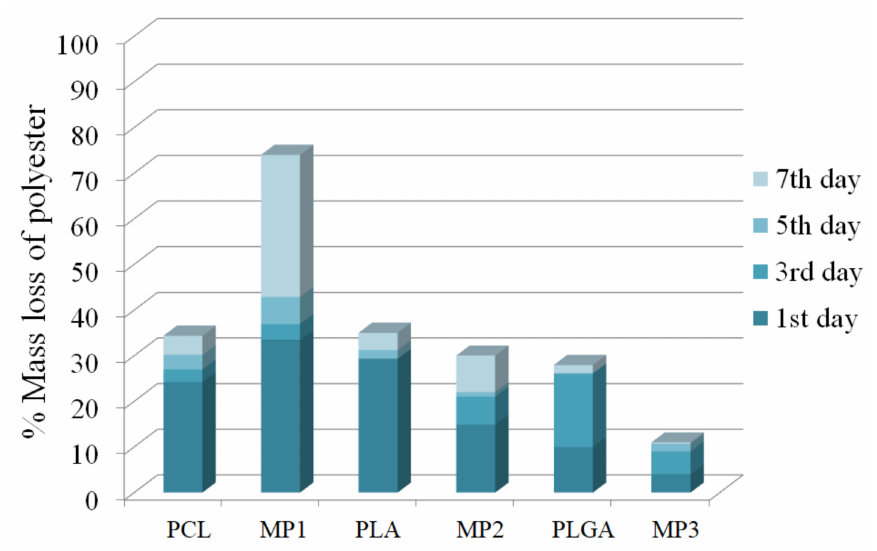
Figure 7. Percentage of mass loss of polyesters as well as a polyester segment in miktostars during the course of enzymatic